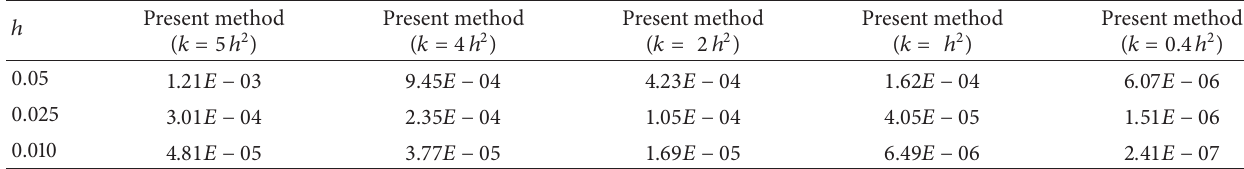
Table 7: Relative errors of numerical method at 𝑢 (0.6, 1.0) for Example 3 with different time step size and various values of space step.